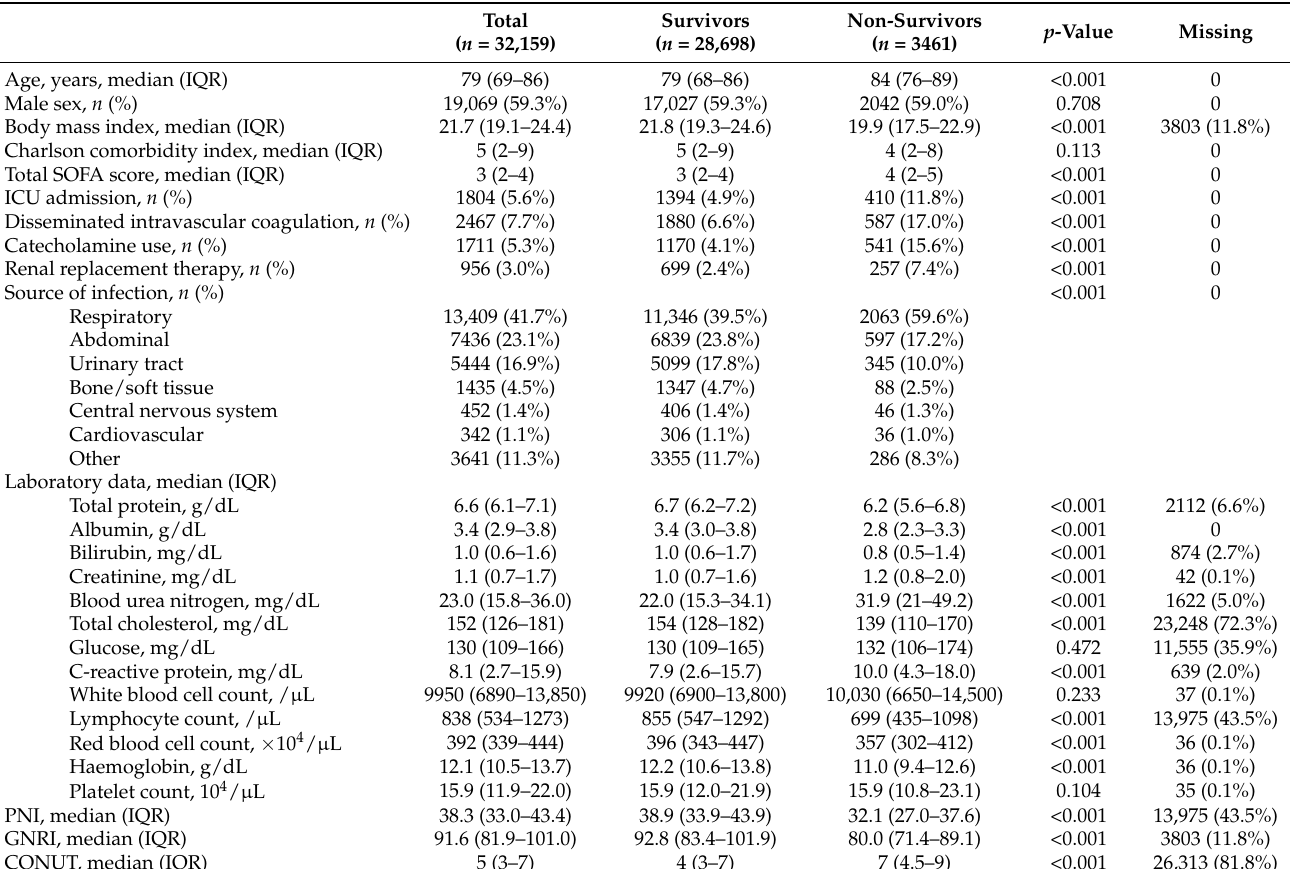
Table 2. Patient characteristics.